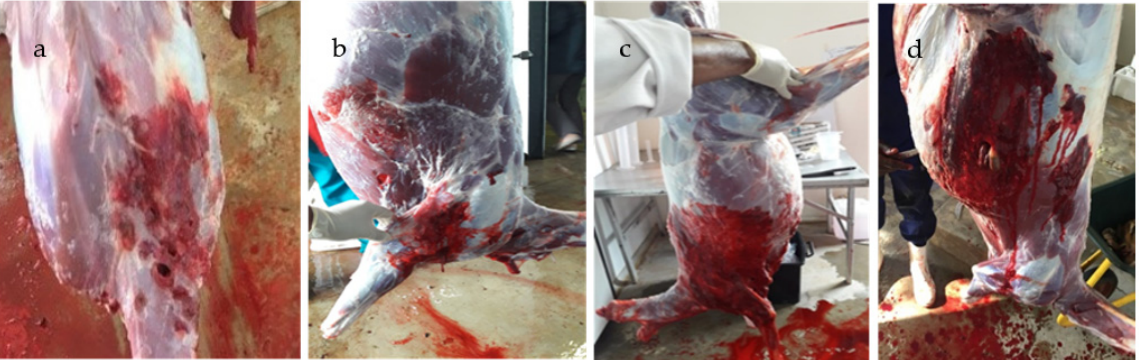
Figure 1. Wound images caused by ( a ) shotgun pellets ( b , c ) land-based rifle bullet shots entry ( d ) land-based rifle bullet shots exit. ( d ) land-based rifle bullet shots